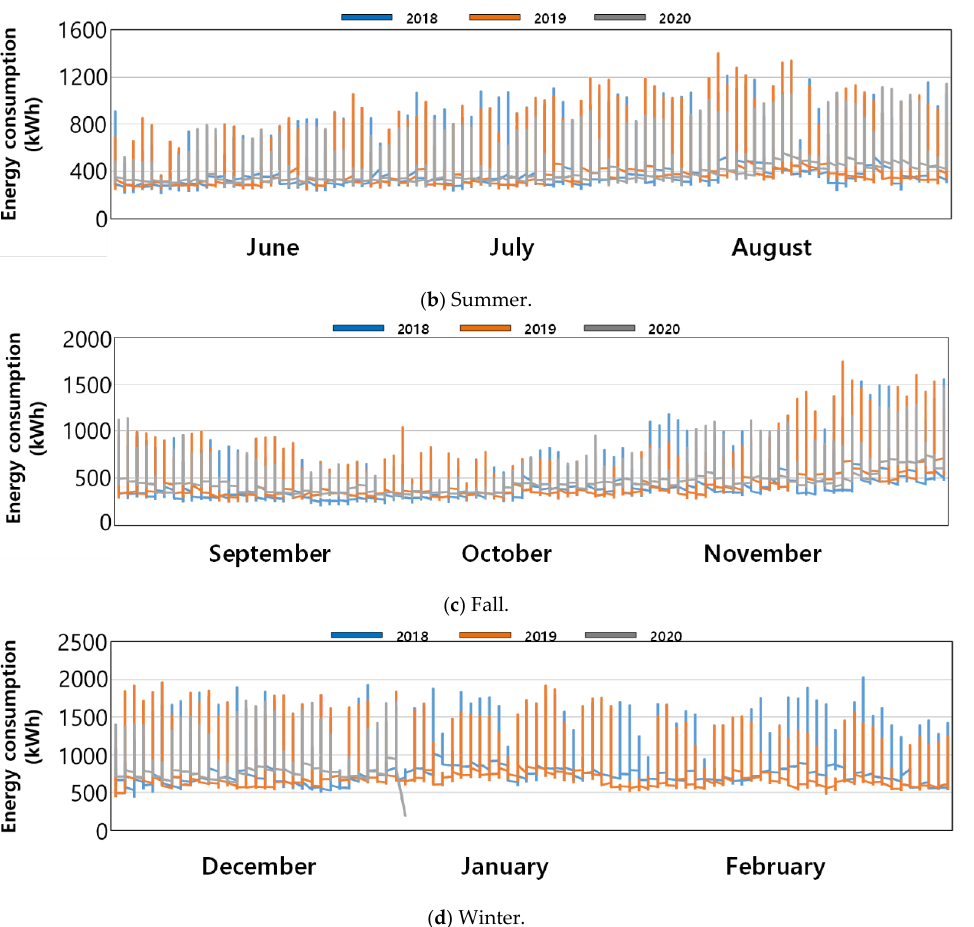
Figure 3. Seasonal hourly energy consumption data of the A community buildings for three years. Table 4. Seasonal energy consumption and the hourly average of the A community buildings for three years.